Question: Condense the content of this figure into a single sentence.
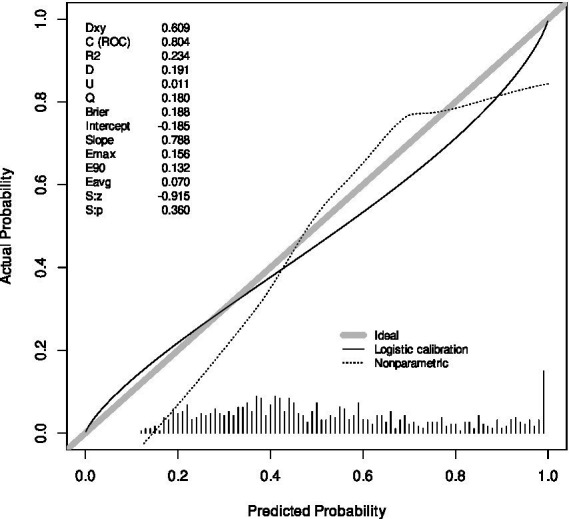
Answer: Calibration curve of the nomogram in the validation set. The diagonal dashed line (“ideal”) represents perfect calibration (predicted probability equals observed probability). The green line (“apparent”) shows the unadjusted calibration performance, while the blue line (“bias-corrected”) applies bootstrap correction (1,000 resamples) for optimism. The closer the bias-corrected curve lies to the ideal line, the better the calibration.